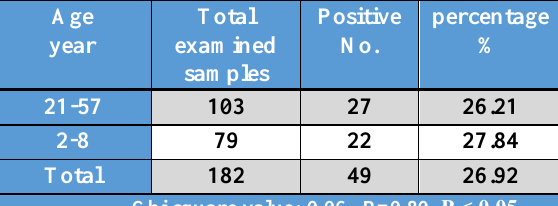
Table, 3: Prevalence of Giardia lamblia according to age in asymptomatic patients Age year